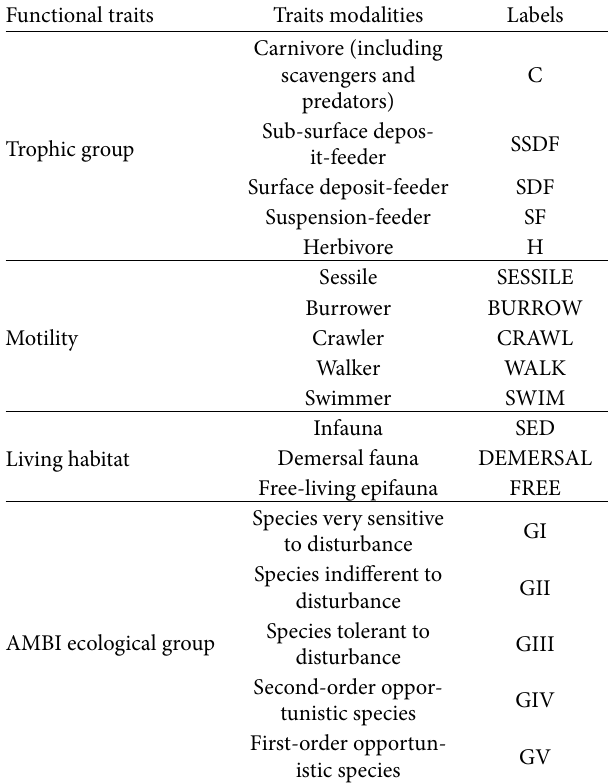
Table 2: List of macrobenthic functional traits evaluated in the present study exhibiting different